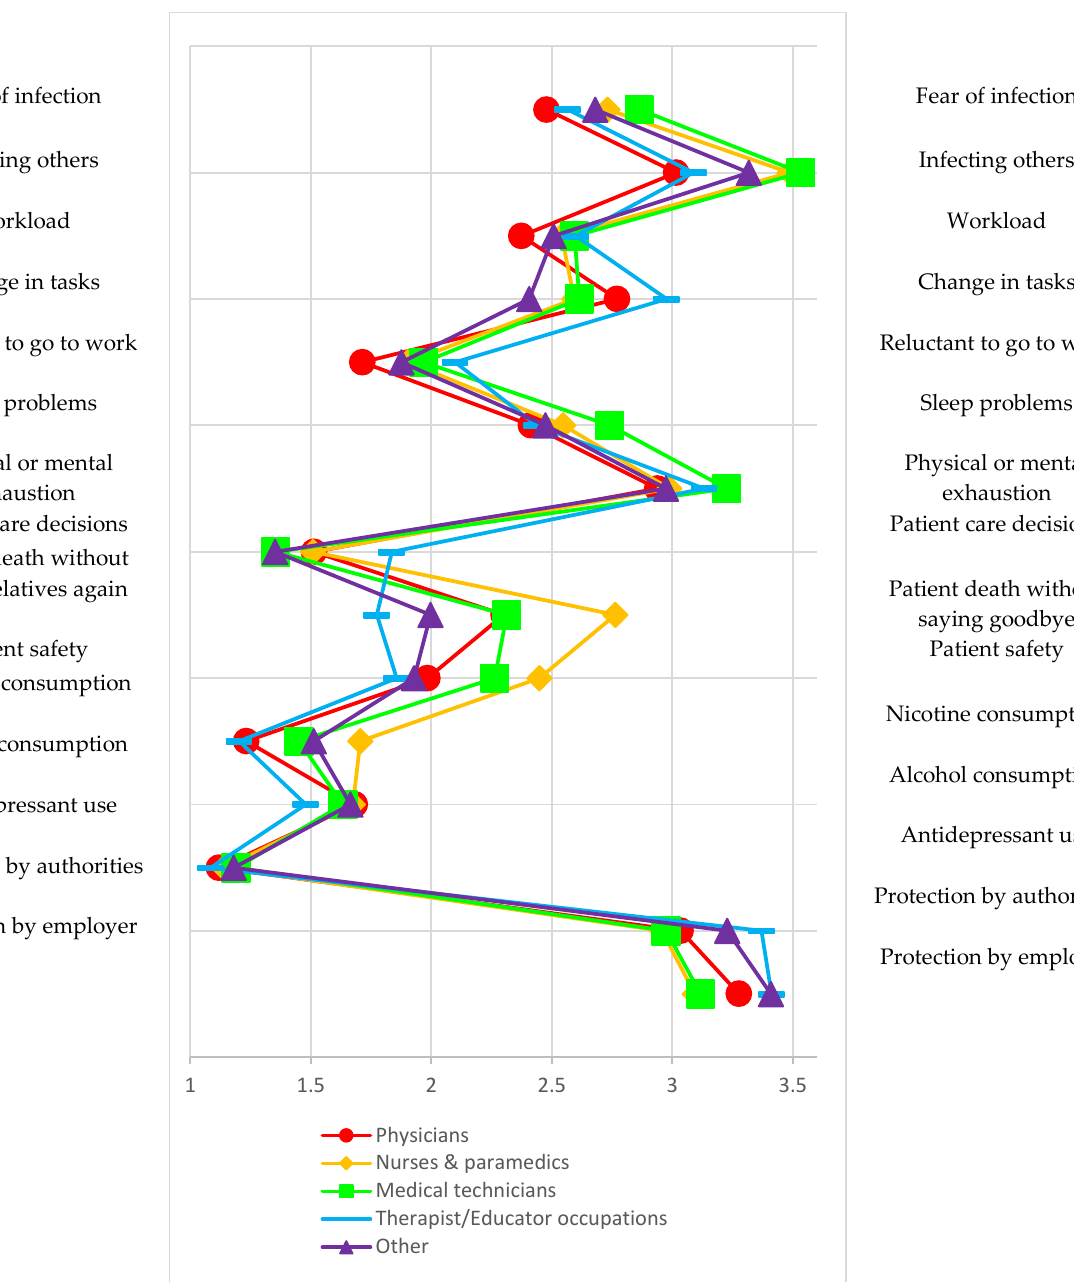
Figure 1. Distribution of characteristics of COVID-19-associated problems and protective factors among different occupational groups.